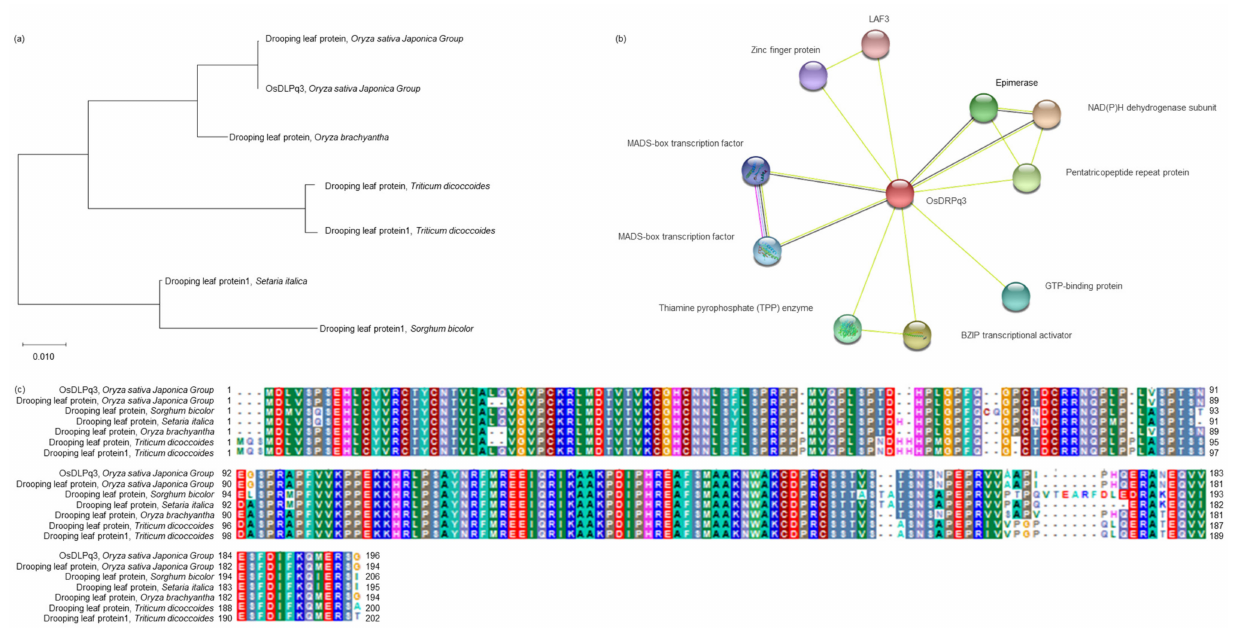
Figure 6. Homology analysis of OsDRPq3 . ( a ) OsDRPq3 has very high homology to genes related to awn elongation in wheat, barley, and sorghum belonging to Gramineae. ( b ) OsDRPq3 was analyzed with very high homology with drooping leaf protein of crops belonging to Gramineae. ( c ) Especially when predicting protein interaction, OsDRPq3 is associated with genes related to signaling and awn development. OsDRPq3 can be effectively used to breed high yield rice without awn in the